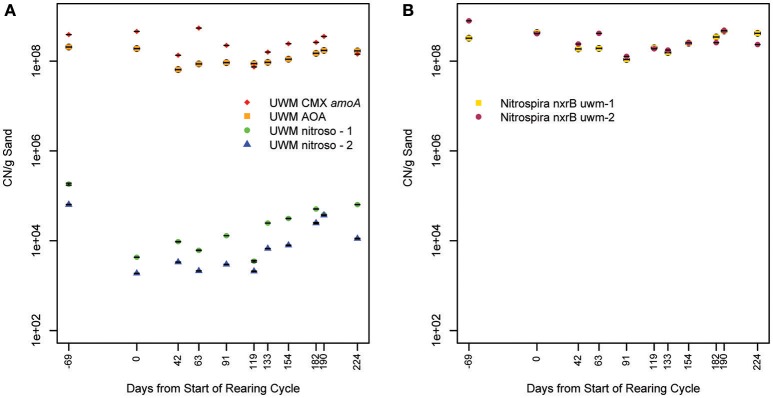
Nitrification marker gene concentration over time. Plot (A) illustrates amoA copy number (CN) per gram of biofilter sand and plot (B)
nxrB CN per gram of biofilter sand for all identified genotypes. Standard deviation of triplicate qPCR reactions is indicated for each sample. The x-axis indicates time, with timepoint 0 representing the beginning of one fish rearing cycle. Samples collected in the previous rearing cycle are labeled with negative values. See Table S1 for sample metadata.